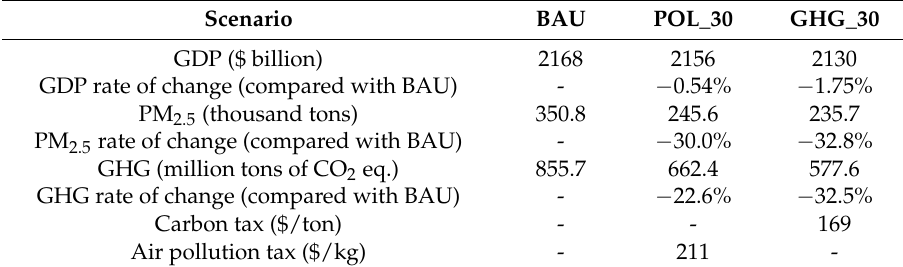
Table 10. Impact on gross domestic product (GDP) and emissions.